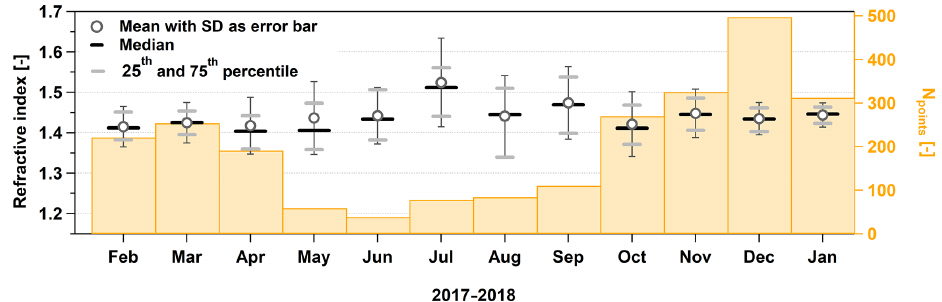
Figure 5. The monthly averages (with error bars as the standard deviation), medians, and percentiles of RI eff from coastal Antarctica, measured at λ = 633nm for dry aerosol particles. The orange bars refer to the right axis and show the number of successful RI retrievals in the corresponding month. Table 1. The monthly and yearly ( P ) averages, standard deviations (SD), medians, and percentiles of the RI eff from coastal Antarctica, measured at λ = 633nm for dry aerosol particles. Month 25th Median 75th Mean SD N points percentile percentile